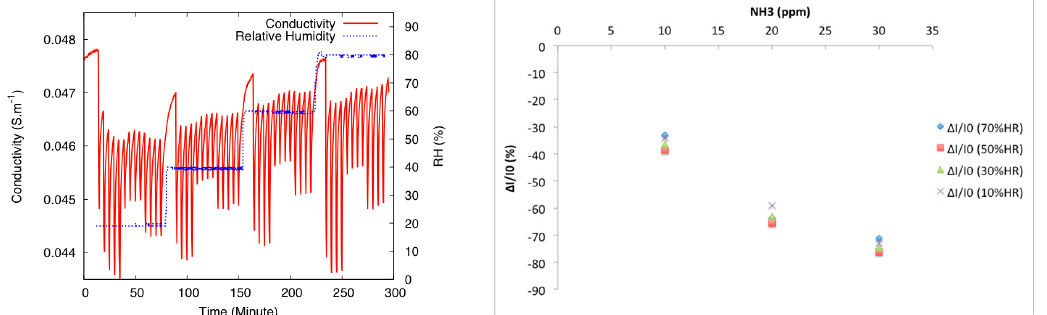
Figure 5. Conductivity variation of a PPy/s-CoPc resistor as a function of time during 1 min/4 min exposure/recovery cycles to 90, 25 and 45 ppm NH3 in synthetic air, at different relative humidity values ( left ) and the relative response ( Δ I/I0) of a (PPy/CuTsPc) device as a function of the NH3 concentration at various RH values, as calculated from four 0.25 min/1 min exposure/recovery cycles ( right